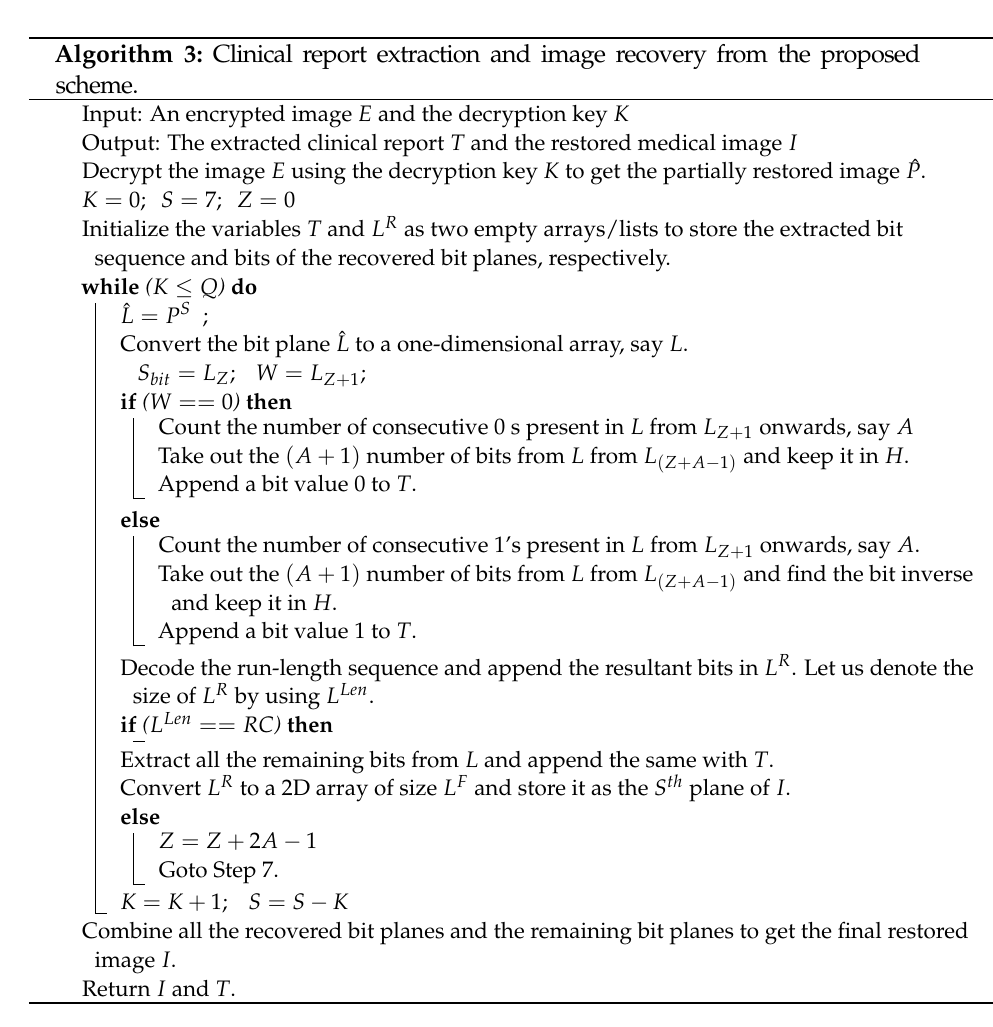
Algorithm 3: Clinical report extraction and image recovery from the proposed